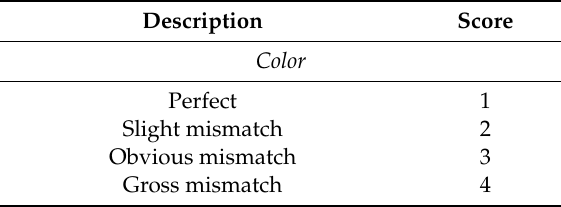
Table 3. Description of the Manchester scar scale